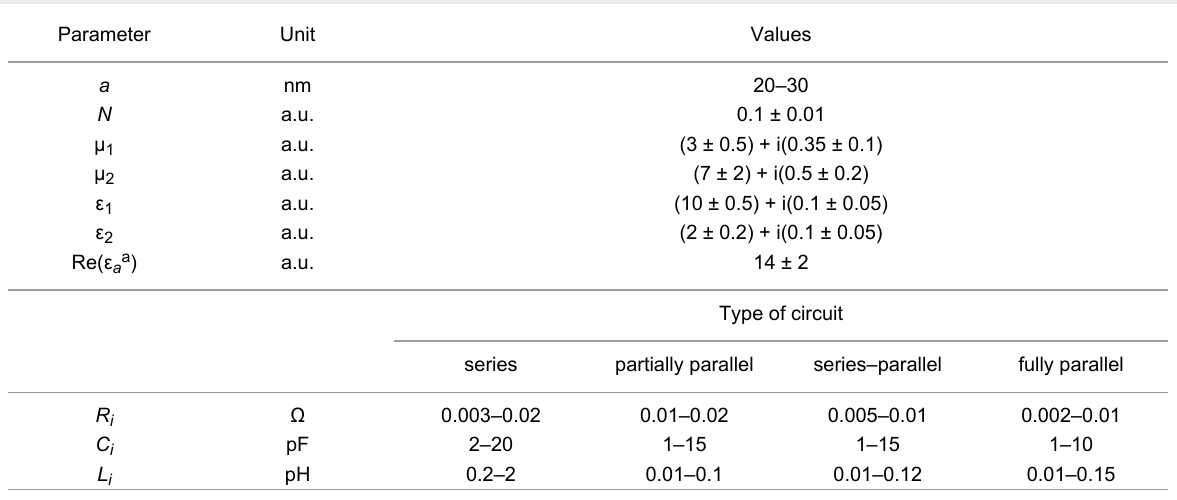
Table 1: Values of input parameters used in the model. Parameter